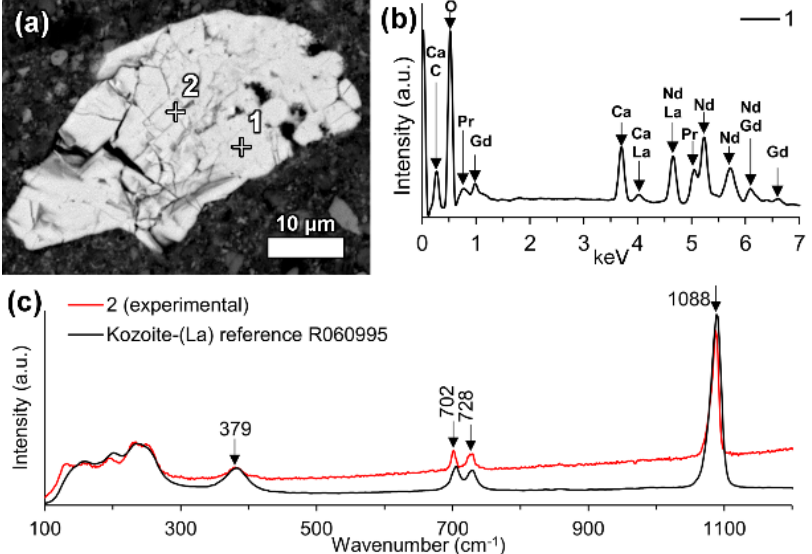
Figure 5. An ancylite group LREE carbonate phase depicted on ( a ) backscattered electron image with its ( b ) EDS spectrum and ( c ) Raman spectrum compared to a reference spectrum of kozoite-(La) obtained from RRUFF database [61], with permission from RRUFF™. Raman spectrum collected with a 532-nm wavelength laser.